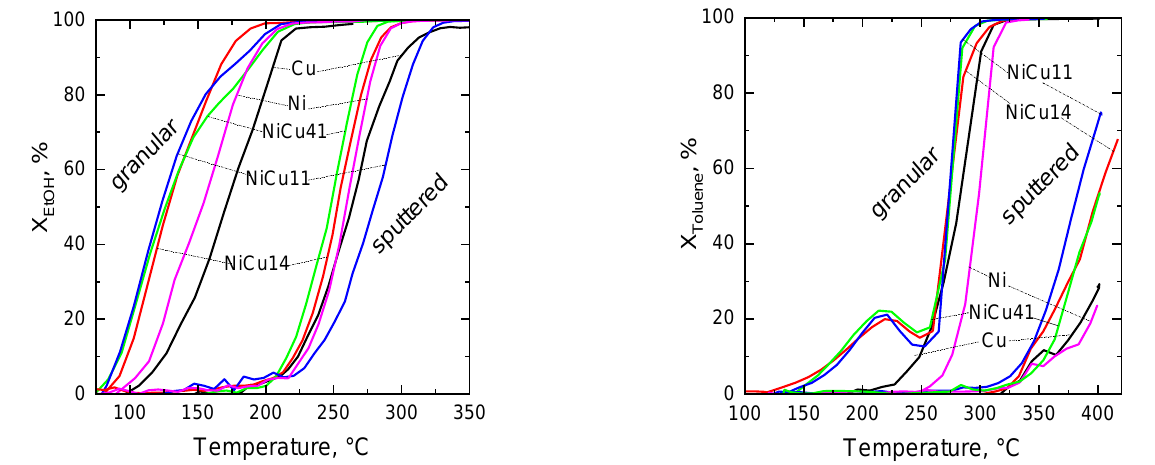
Figure 7. Conversion curves of ethanol ( left ) and toluene ( right ) obtained during their oxidation over granular and sputtered catalysts. Catalysts Cu (black), NiCu14 (red), NiCu11 (blue), NiCu41 (green), and Ni (magenta). Reaction conditions: 0.2 g of granular catalyst or 3.8 g of sputtered catalysts, 760 ppm of ethanol or 780 ppm of toluene, GHSV 21 L g cat−l h −l , temperature ramp 2 °C min −l . Table 7. Temperatures T 50 and T 90 CO 2 , ◦ C, and specific reaction rate R T observed in the oxidation of ethanol and toluene over granular and sputtered catalysts. Reaction conditions: 0.2 g of granular cat- alyst or 3.8 g of sputtered catalysts, 760 ppm of ethanol or 780 ppm of toluene, GHSV 21 L g cat − l h − l , temperature ramp 2 ◦ C min − l